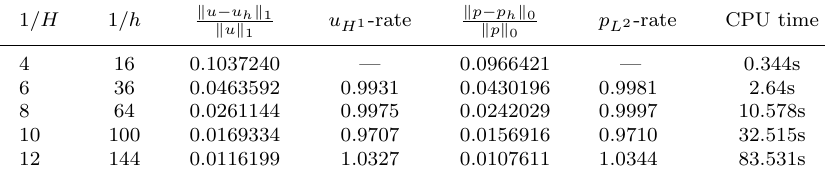
Table 1. Relative error and convergence rate of the two-grid method for the velocity and flux with τ 2 = h and ν = 1. 1